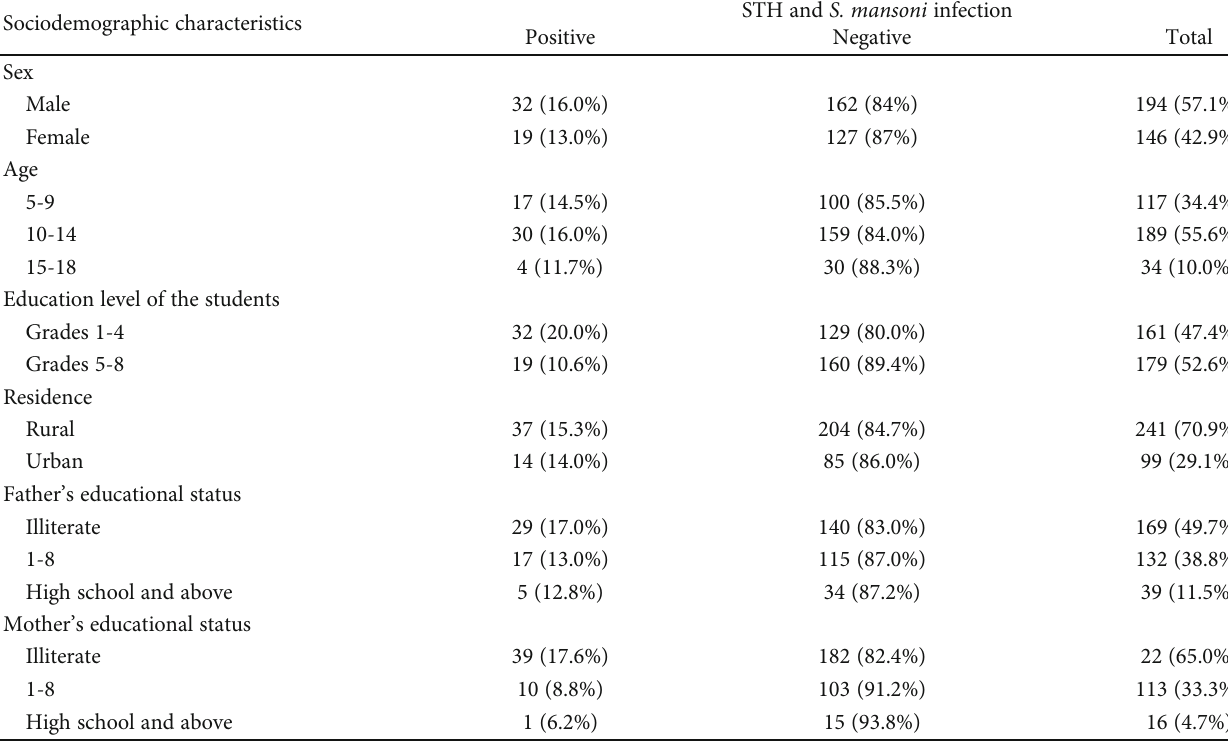
Table 1: STH and S. mansoni infections with sociodemographic factors among Hiruy Abaregawi primary school children from March to April, 2019, Debre Tabor Town, North West